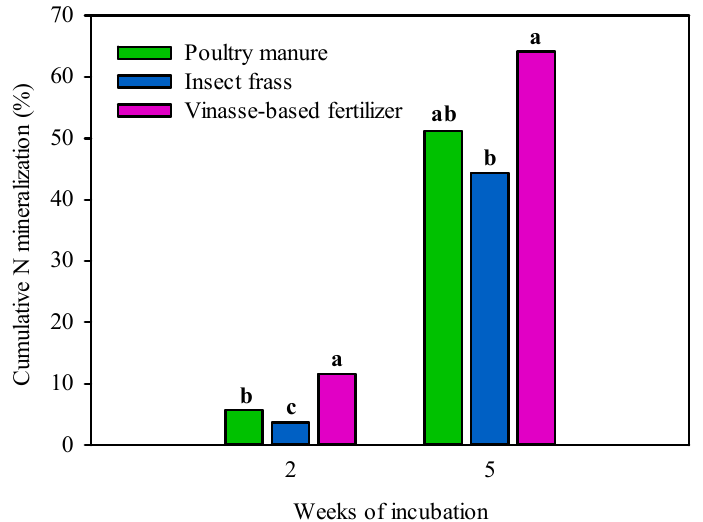
Figure 1. Mean cumulative N mineralization by fertilizer type at 2 and 5 weeks of aerobic incubation of soil: fertilizer blends. Mean square error at 2 wk = 0.53; Mean square error at 5 wk = 145.85; Coefficient of variation at 2 wk = 46.8%; Coefficient of variation at 5 wk = 26.9%; Tukey’s least significant difference (5%) at 2 wk = 0.92; Tukey’s least significant difference (5%) at 5 wk = 15.22 Different letters within each week of incubation indicate significant differences according to Tukey’s range test (5%).